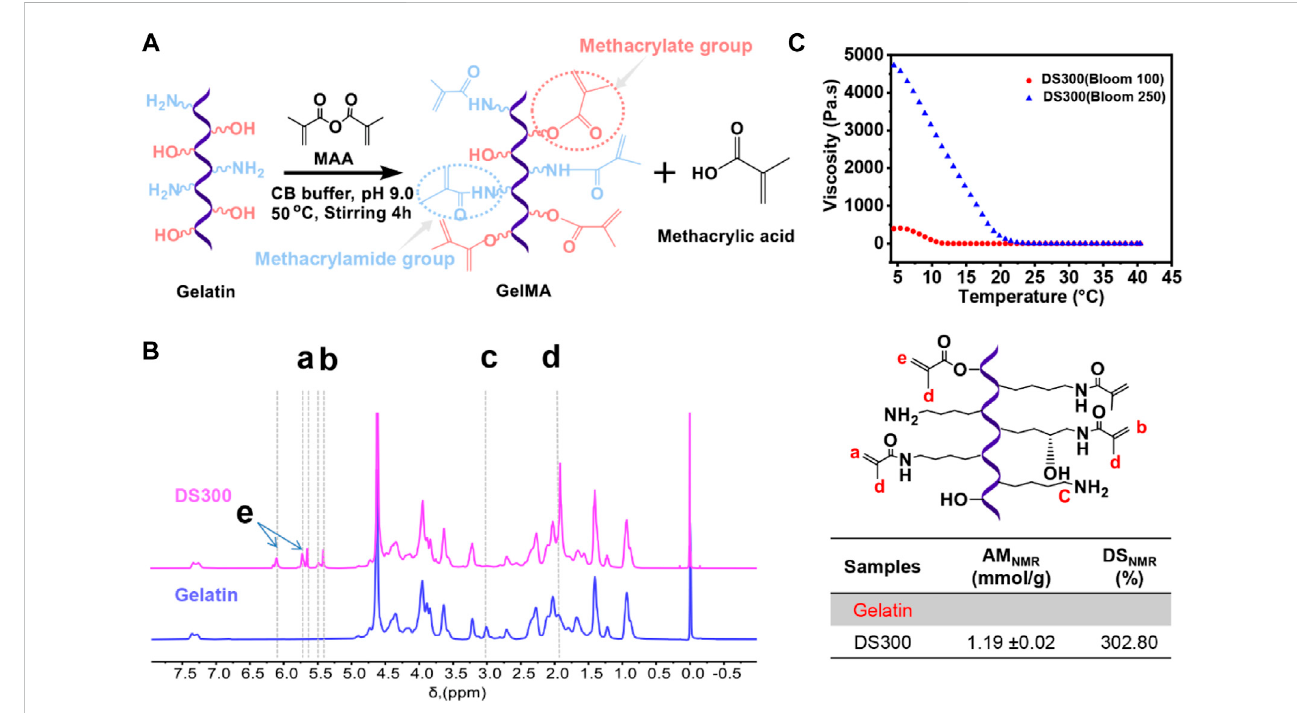
FIGURE 1 (A) Schematic illustration of GelMA (gelatin methacryloyl) synthesis via reaction of gelatin with methacrylic anhydride. (B) Viscosity of a GelMA solution (30 w/v%) at temperatures ranging from 4 ° C to 40 ° C with different blooms (blue line: 250 bloom, red line: 100 bloom). (C) 1 H NMR veri fi cation of gelatin and GelMA. Peaks correspond to acrylic protons (2H) of methacryloyl grafts of lysine groups and hydroxyl lysine groups , (a, b), methylene protons (2H) of unreacted lysine groups (C) , methyl protons (3H) of methacryloyl grafts (d), and acrylic protons (2H) of methacrylated grafts of hydroxyl groups